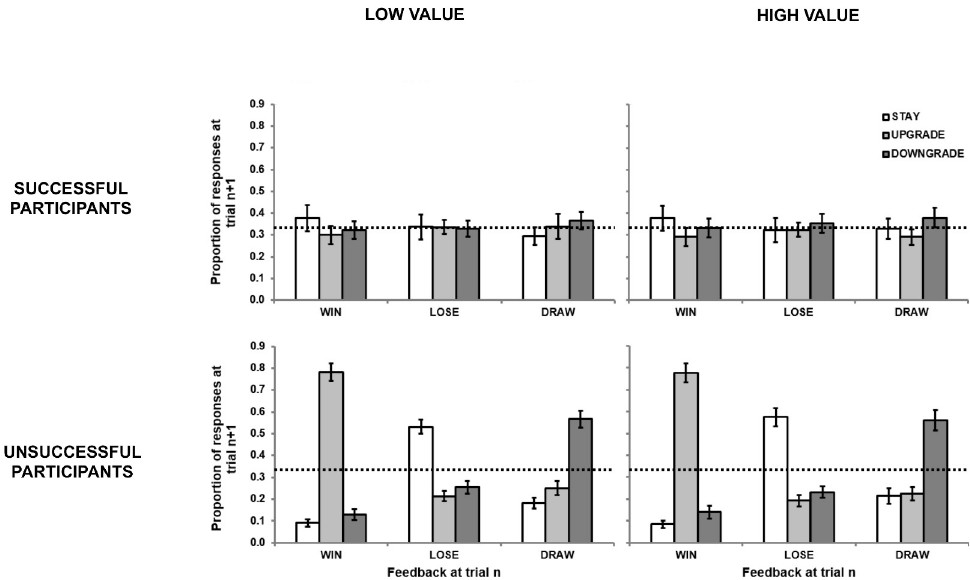
Fig 4. Proportion response data from unsuccessful and successful participants in the exploitable condition of Experiment 2 in terms of the relationship between outcome at trial n ( win , lose , draw ) and the strategy selected at trial n+1 ( stay , downgrade , upgrade ). Error bars represent standard